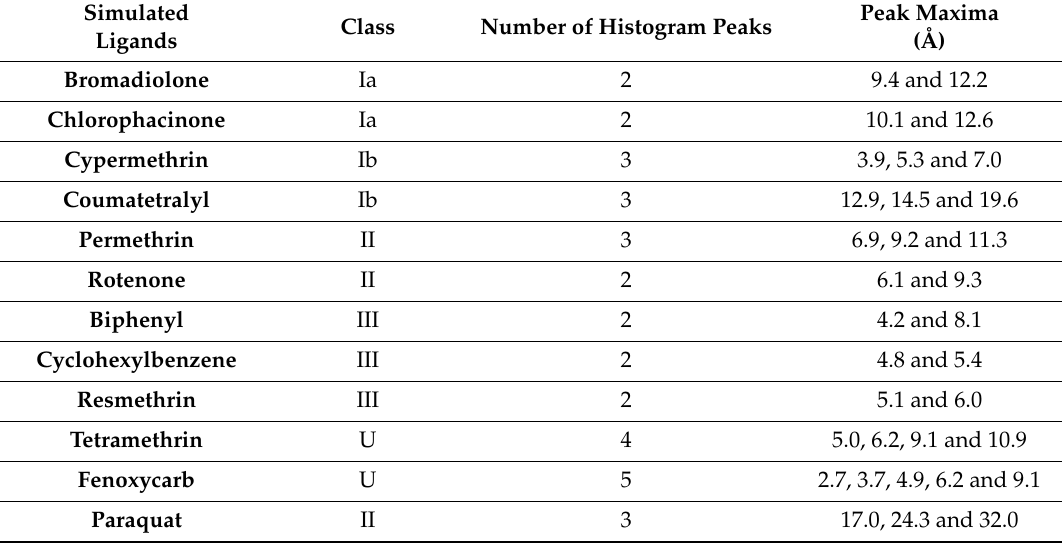
Table 2. Analysis of the CMdist frequency histograms for the simulated complexes of 1GXA-pesticide. Simulated